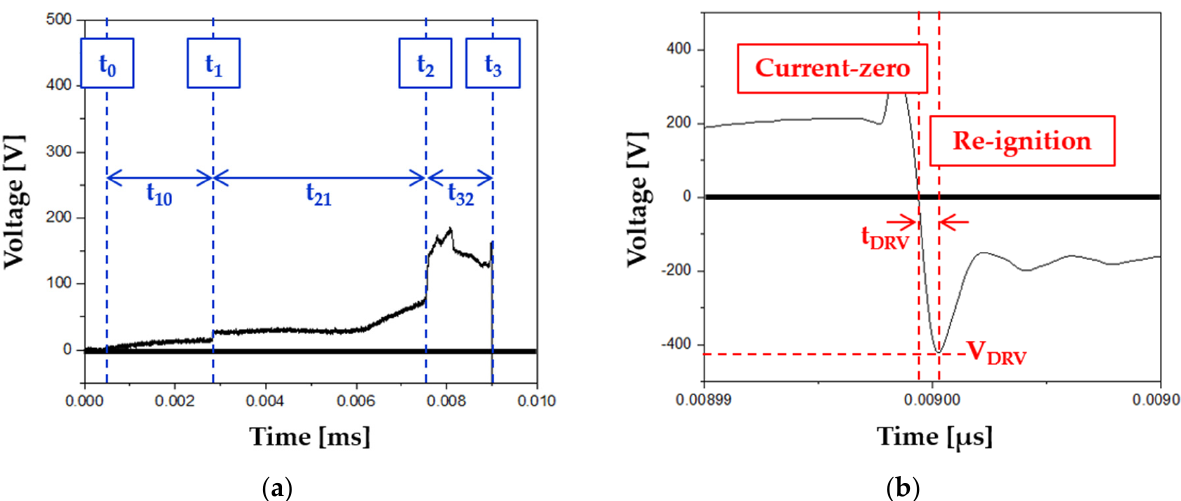
Figure 4. Schematics of measurement points. ( a ) Short-circuit characteristics, ( b ) Dielectric recovery voltage.